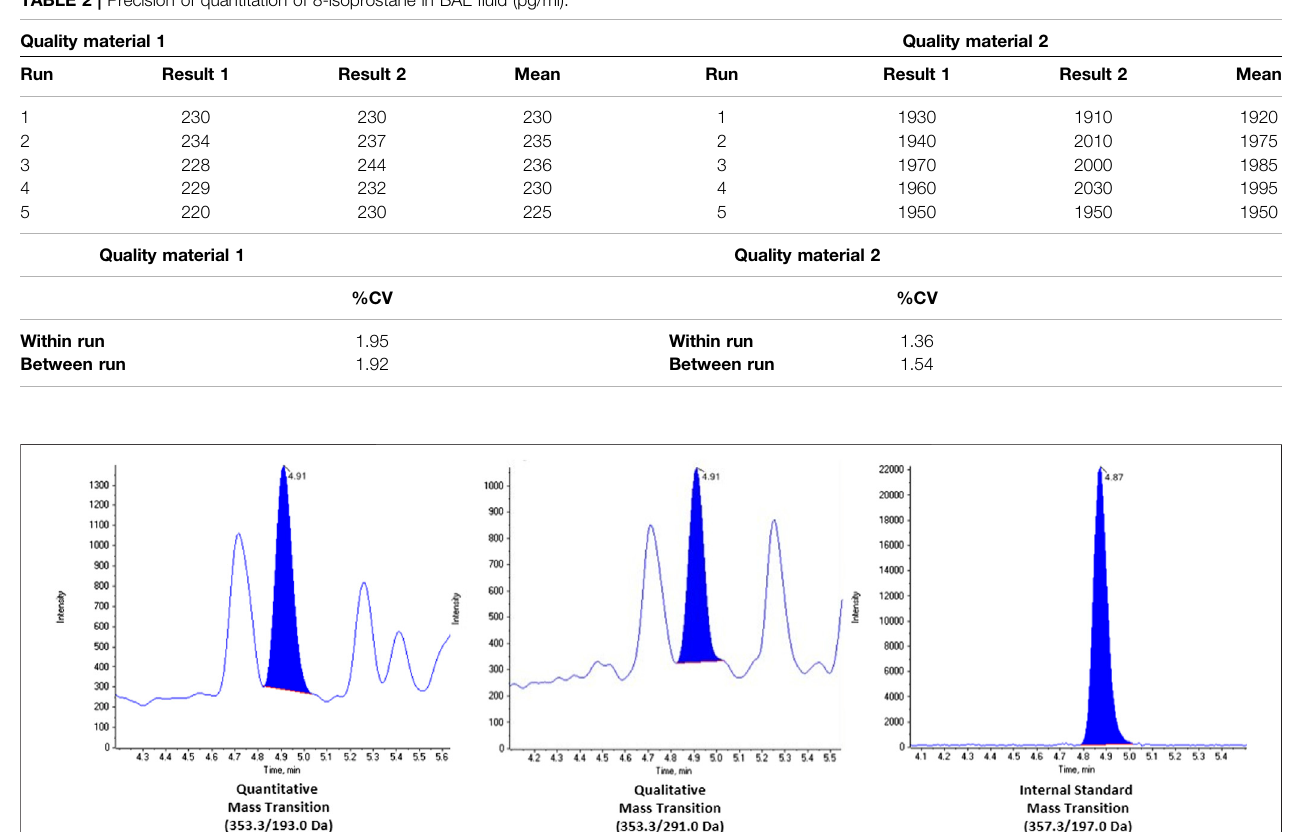
FIGURE 1 | Chromatograms of real BAL fl uid sample with concentration 437 pg/ml. The mass transitions for each channel are as follows: quantitative (353.3/ 193.0 Da), qualitative (353.3/291.0 da), and internal standard (353.3/197.0